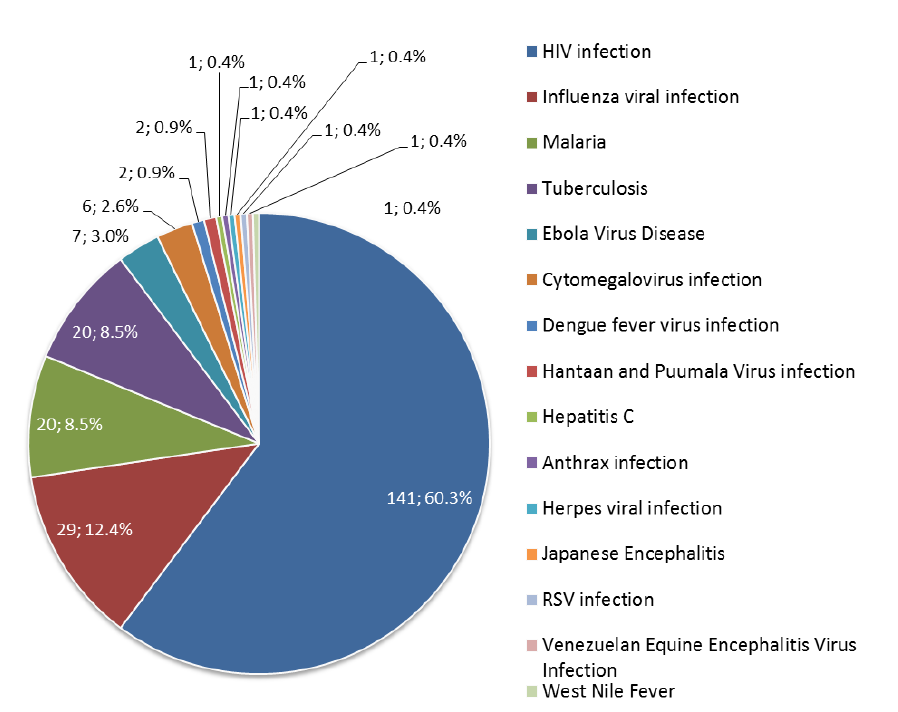
Figure 2. Diseases targeted by prophylactic gene-based